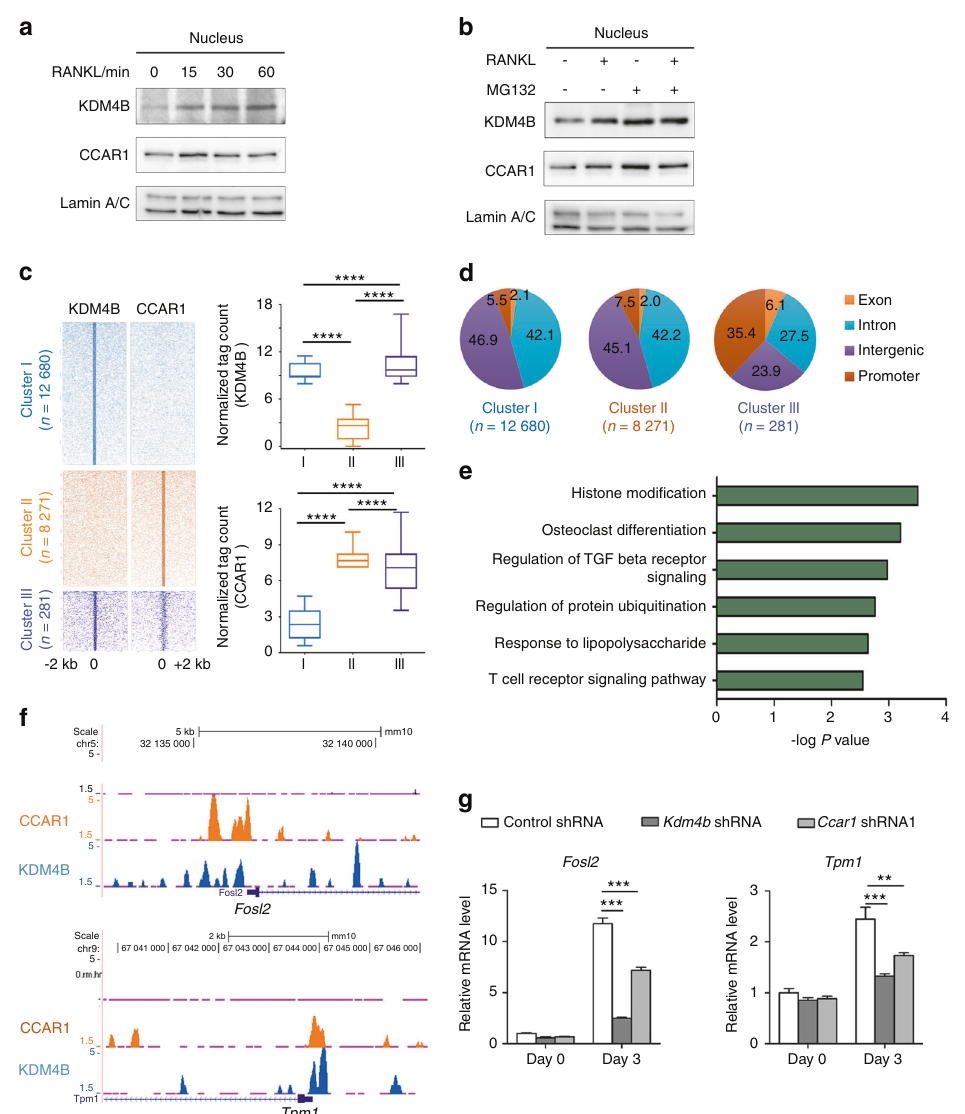
Fig. 3 KDM4B and CCAR1 are colocalized near TSSs and enhance the gene expression of a set of osteoclast-related genes. a Immunoblots of nuclear fractions of BMMs after RANKL treatment. b KDM4B stabilization by RANKL or MG132. c Heatmap of normalized tag densities on KDM4B and CCAR1 peaks (left panels). Quanti fi cations of tag counts are shown in the box plots (right panels). The boxes enclose the 25th to 75th percentile values. The whiskers extend to the 10th and 90th percentiles. The central horizontal bar indicates the median. **** P < 0.000 1 (Kolmogorov – Smirnov test). d Genomic locations of binding sites within each cluster are expressed as percentages of the total binding sites. e Gene Ontology (GO) enrichment analysis of Cluster III. f Representative UCSC Genome Browser tracks showing co-occupancy of KDM4B and CCAR1 at Fosl2 and Tpm1 . g mRNA expression levels of Fosl2 and Tpm1 in cells expressing control shRNA, Kdm4b shRNA, or Ccar1 shRNA1. The data are presented as the mean ± SD of three independent experiments (two-way ANOVA). ** P < 0.01; *** P < 0.001. See also Supplementary Fig.